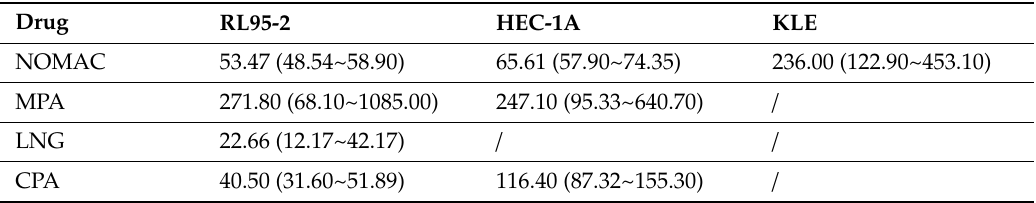
Table 1. Antiproliferative activity of various progestins on three types of human endometrial cell lines after treatment for 48 h, as presented as IC 50 (95% confidence interval) values ( µ